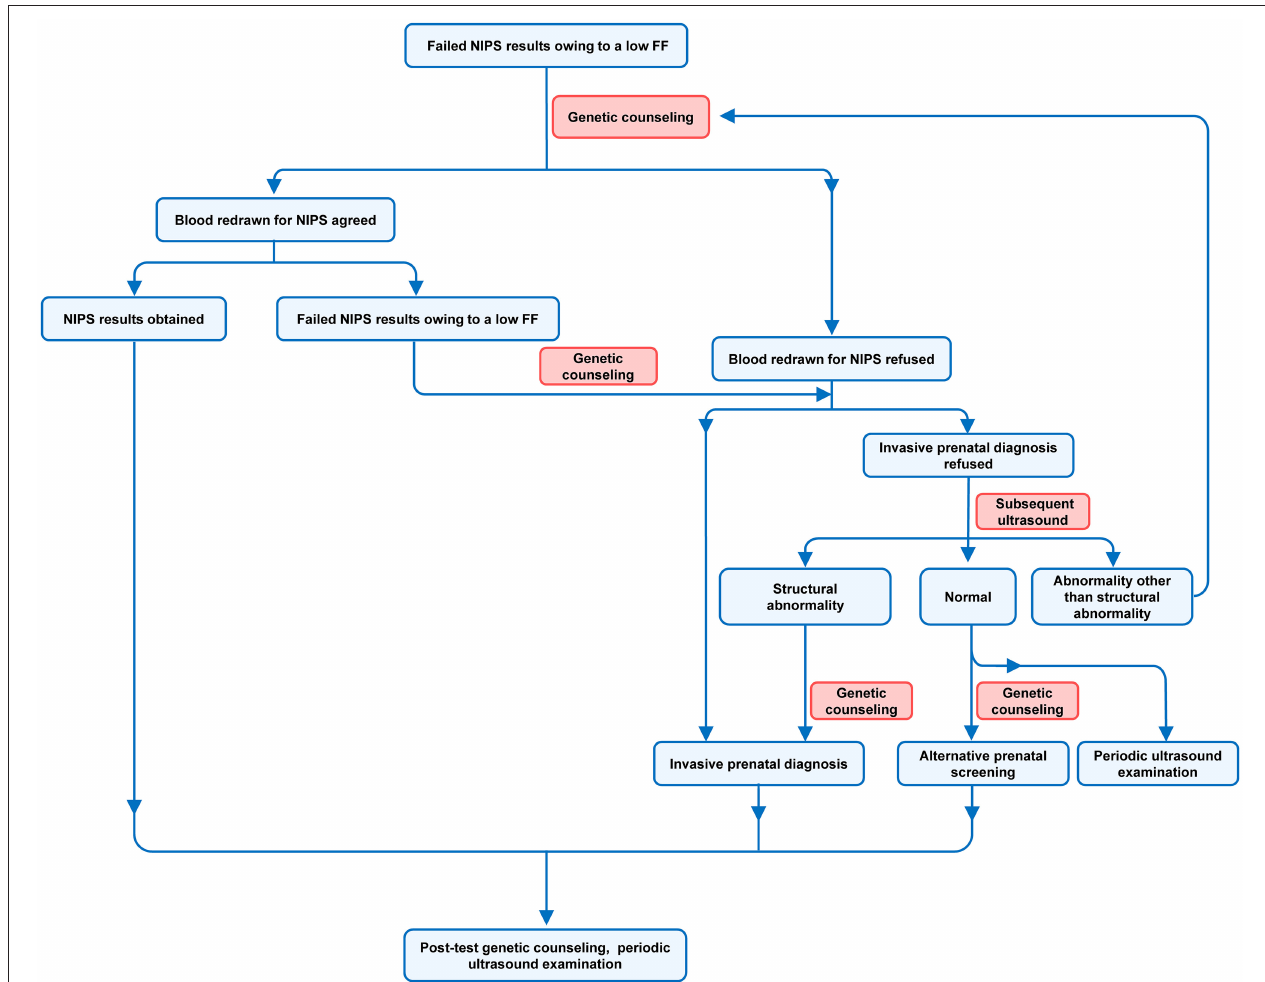
FIGURE 2 | Management procedures of pregnant women with failed results owing to a low